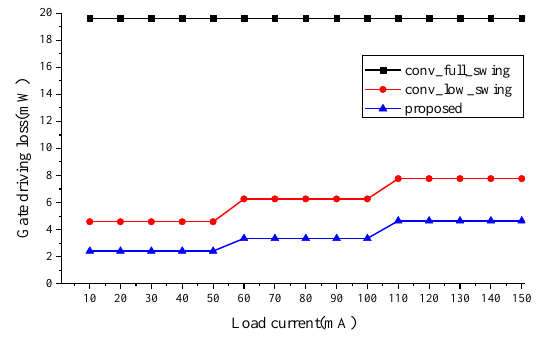
Figure 10. Measured gate driving loss of buck converters.